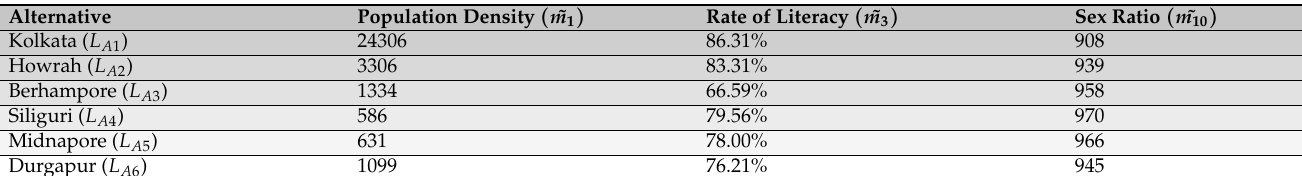
Table 12. Fixed data for Population density ( ˜ m 1 ) , Rate of Literacy ( ˜ m 3 ) & Sex Ratio ( ˜ m 10 ) .